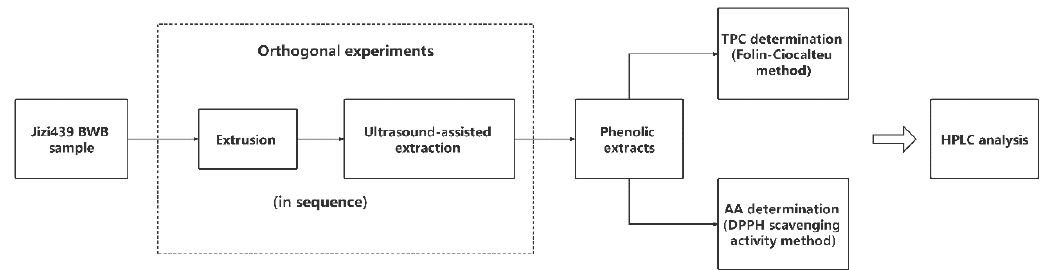
Figure 1. Scheme of optimizing Jizi439 black wheat bran (BWB) processing steps.